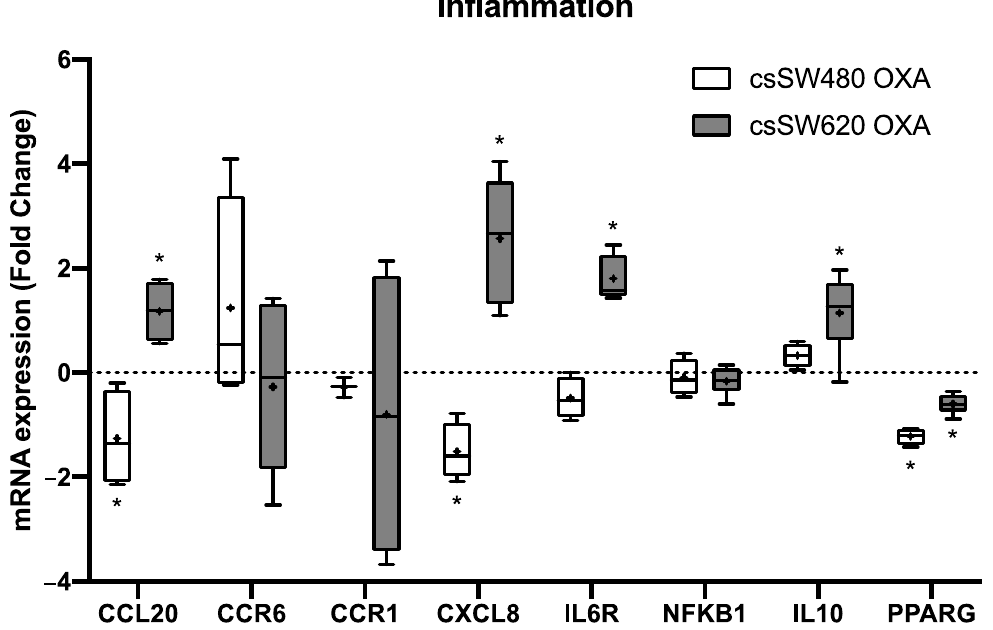
Figure 4. Inflammation marker mRNA expression after 96 h of oxaliplatin 5 µM treatment in SW480 and SW620 tumourspheres. Each box represents the interquartile range (25th to 75th percentiles), the central horizontal line is the median value, and the whiskers represent the minimum and the maximum values ( n ≥ 4). Student’s test or Mann–Whitney test were performed to determine the significance between the experimental groups. Statistical significance was set at * p < 0.05.